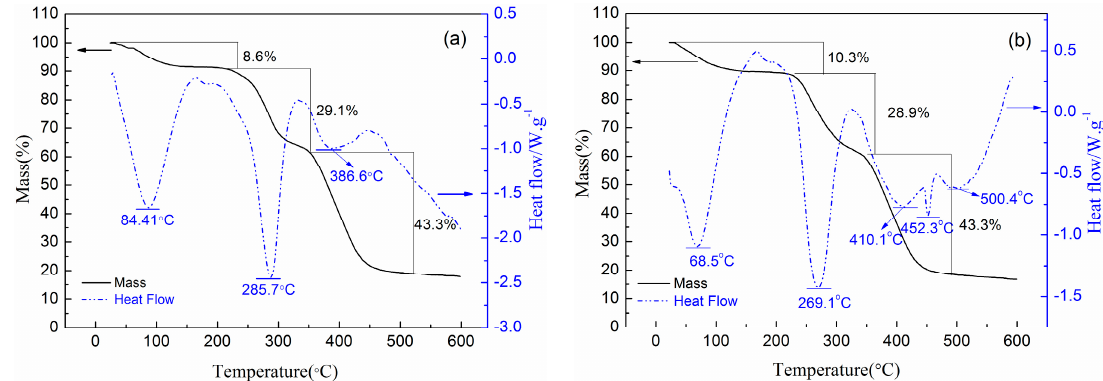
Figure 6. Differential scanning calorimetry and thermogravimetric analysis (DSC − TGA) curves of ( a ) PAD; and ( b ) PAB.